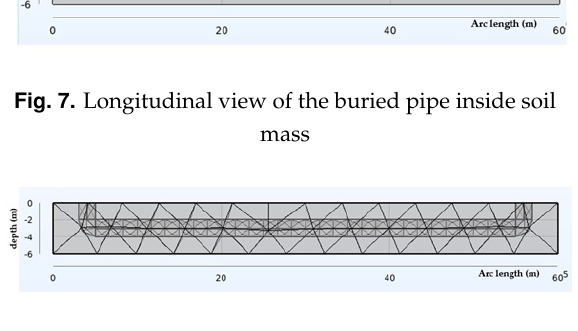
Fig. 8. The meshing of the proposed model (Longitudinal